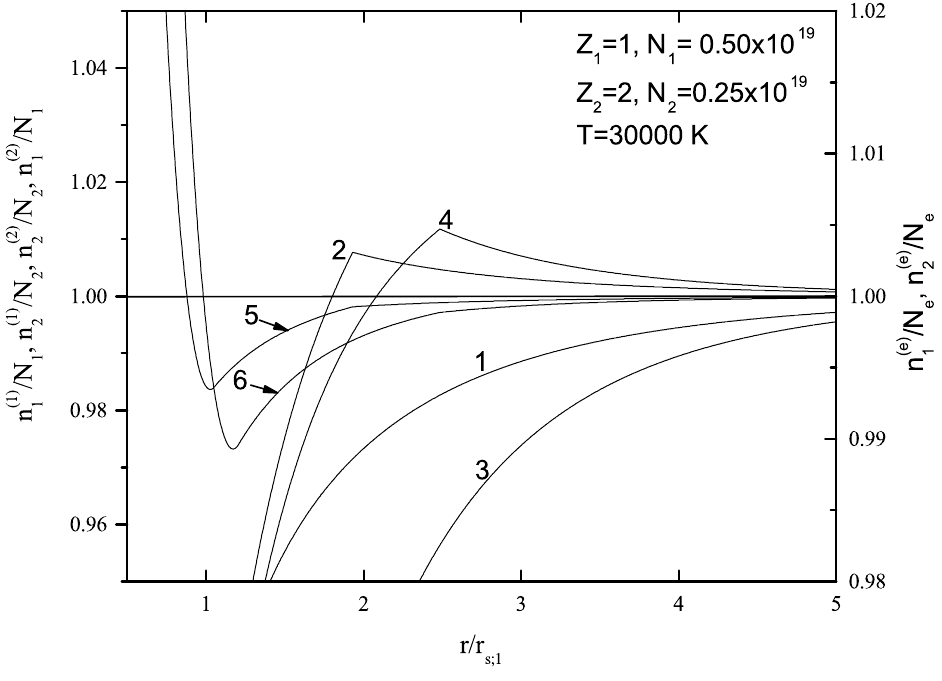
( 1 ) ( r ) / N 1 (curve marked with 1), n 1 ( 2 ) ( r ) / N 1 (curve marked with 4), and n 1